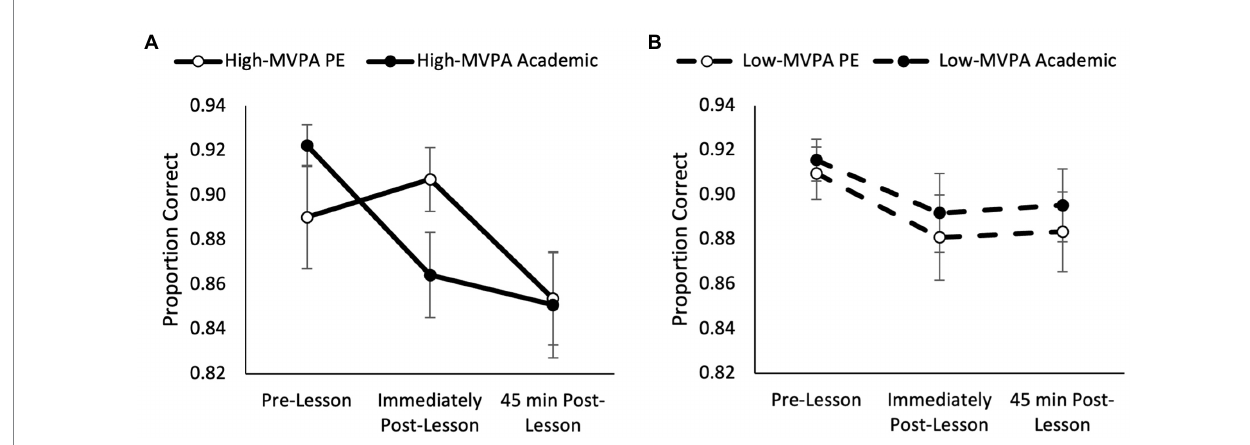
FIGURE 5 Accuracy presented as the proportion of correct responses across the morning on the five item level of the Sternberg paradigm for the high MVPA (trial * time, p = 0.023; A ) and low MVPA (trial * time, p = 0.946; B ) groups (trial * time * MVPA, p =